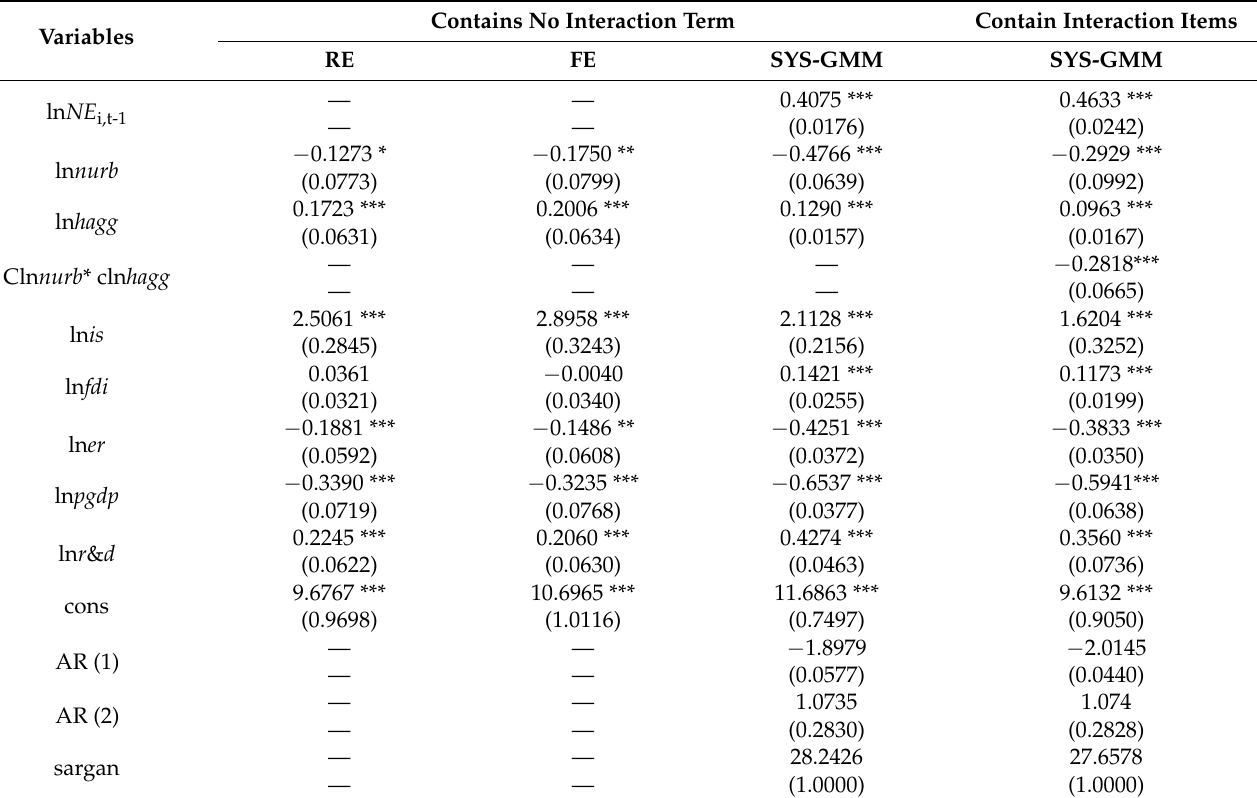
Table 4. Baseline regression